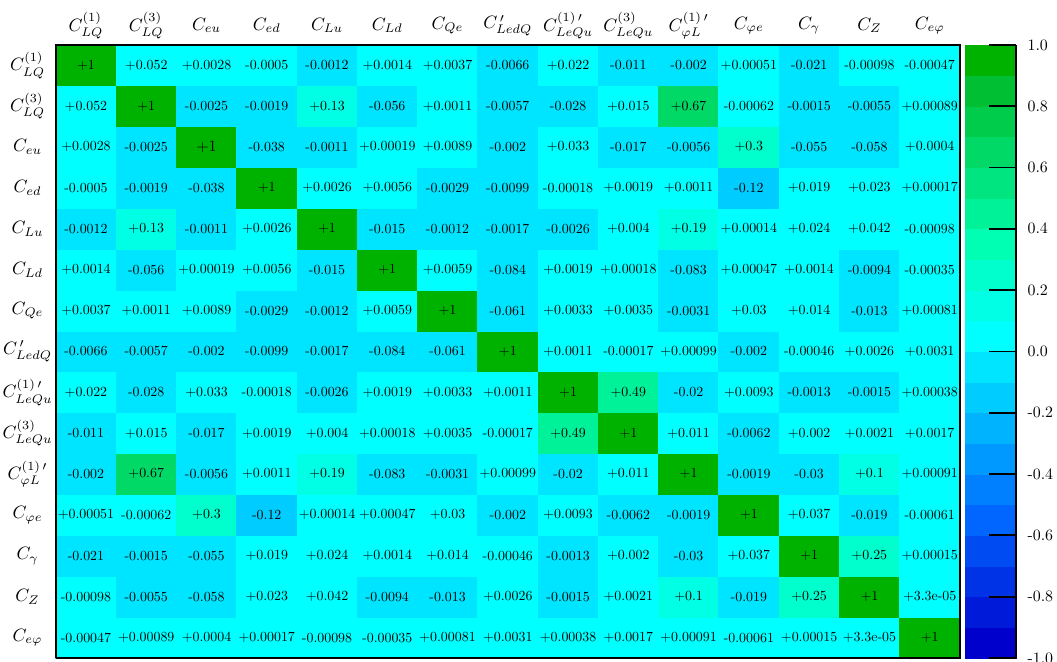
Figure 11 . Correlations among all the Wilson coefficients from the numerical analysis considering Belle limits and excluding FCNCs.